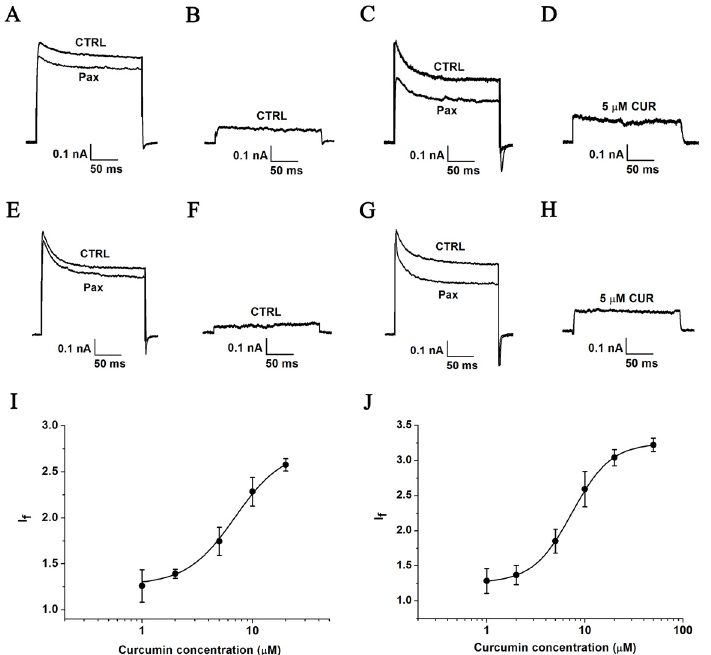
Fig 3. Effect of curcumin on the current density of endogenous BK channels in A7r5 cells. (A) Representative traces of whole cell currents from A7r5 cells in the absence of curcumin before and after application of 10 μ M paxilline. The holding potential was -80 mV and the currents were evoked by +120 mV with 3 μ M free Ca 2+ in the pipette solution. (B) Representative traces of paxilline-sensitive currents in A7r5 cells. (C) The whole cell current traces of A7r5 cells in the presence of curcumin before and after application of 10 μ M paxilline. (D) Representative traces of paxilline-sensitive currents in the presence of curcumin. (E) Representative traces of whole cell currents from A7r5 cells in the absence of curcumin before and after application of 10 μ M paxilline. (F) Representative traces of paxilline-sensitive currents in A7r5 cells. (G) The whole cell current traces of A7r5 cells in the presence of curcumin for 24 hr before and after application of 10 μ M paxilline. (H) Representative traces of paxilline-sensitive currents in the presence of curcumin for 24 hr. (I) The dose-dependence curve of curcumin enhancing current density of BK channels was fitted by the Hill equation (see “ Data analysis ” ). The EC 50 value was assessed to be 6.93 ± 0.78 μ M with a Hill coefficient of n = 2.00 ± 0.55 (n = 6). (J) The dose-dependence curve of curcumin enhancing current density of BK channels was fitted by the Hill equation (see “ Data analysis ” ). The EC 50 value is 7.36 ± 0.10 with Hill coefficient 2.19 ± 0.05 (n =